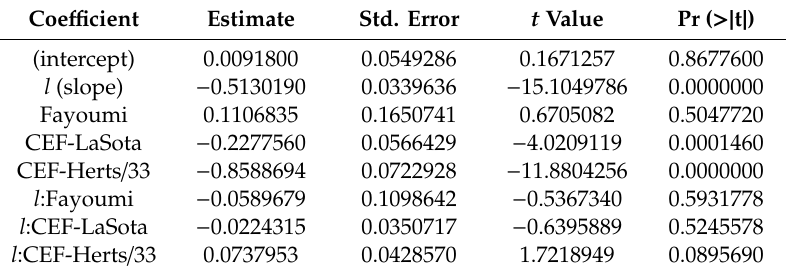
Table 4. Combined linear model for log10 (mRNA fraction) as a function of experiments and length of insertions, weighted by read count (corresponding to inverse variance due to Poisson noise in read